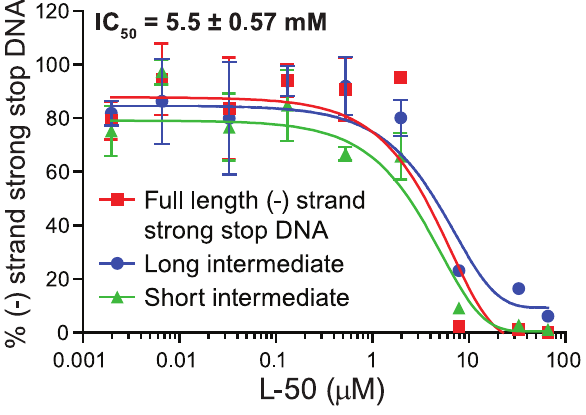
Figure 8. Inhibition of minus strand strong stop DNA synthesis by L50. ( A ) A reconstituted in vitro reverse transcription assay was performed with increasing L50 concentrations to determine the level